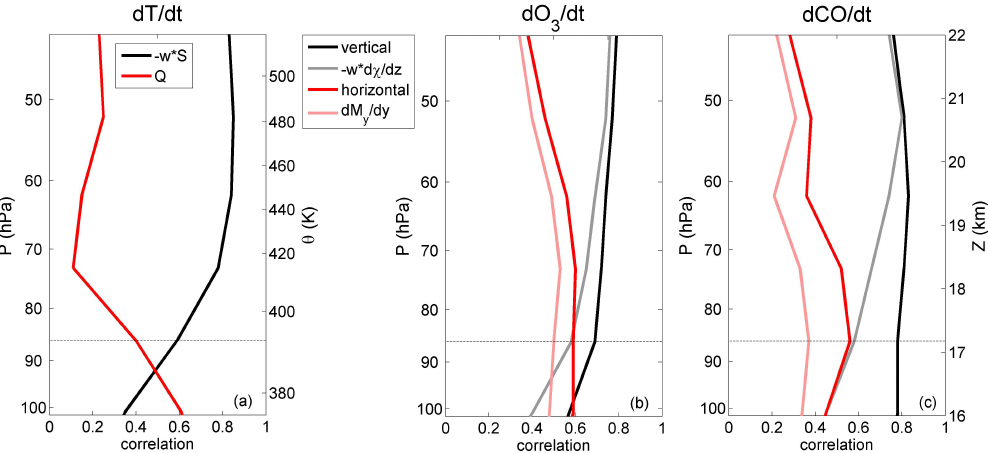
Fig. 13. Correlations between tendencies and forcings for tropical sub-seasonal variability in WACCM. (a) Correlations between sub-seasonal temperature tendency ( ∂ ¯ T/∂t) and vertical advection by tropical upwelling (solid black line). The red line shows correlations of ∂ ¯ T/∂t with the diabatic heating rates ( ¯ Q) . (b) and (c) Correlations of vertical (black) and horizontal (red) components of transport with ozone (b) and CO (c) tendencies. Lines in the washed colors indicate correlations of the tendency with the component that makes the largest contribution to each transport term (tropical upwelling for vertical transport and eddy term for horizontal transport). All series are filtered to isolate sub- seasonal timescales (that is, periods <1yr) before computing the correlations. For reference, the location of annual mean isentropic levels in WACCM is indicated on (a) and the approximate altitude on (c) , estimated as described in Fig. 1. The dashed horizontal lines indicate the location of the annual mean cold point tropopause in